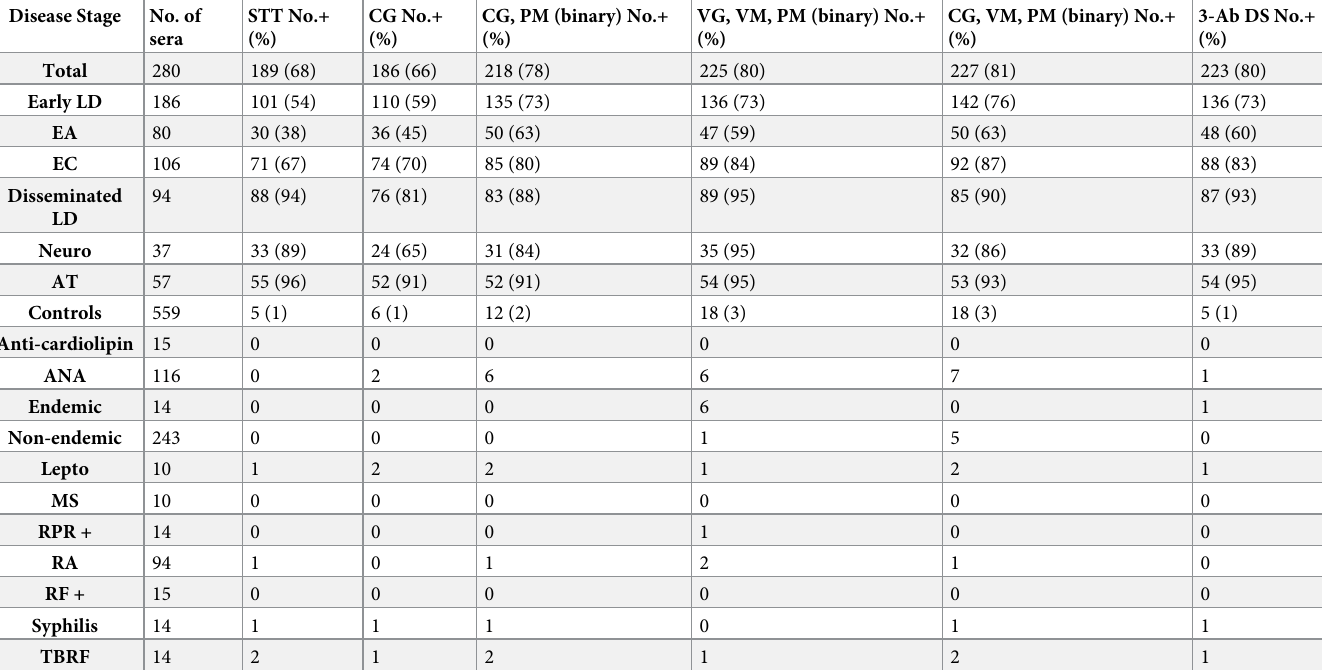
Table 5. STT performance versus C6-IgG, select binary models, and the 3-antibody diagnostic score a,b . Disease